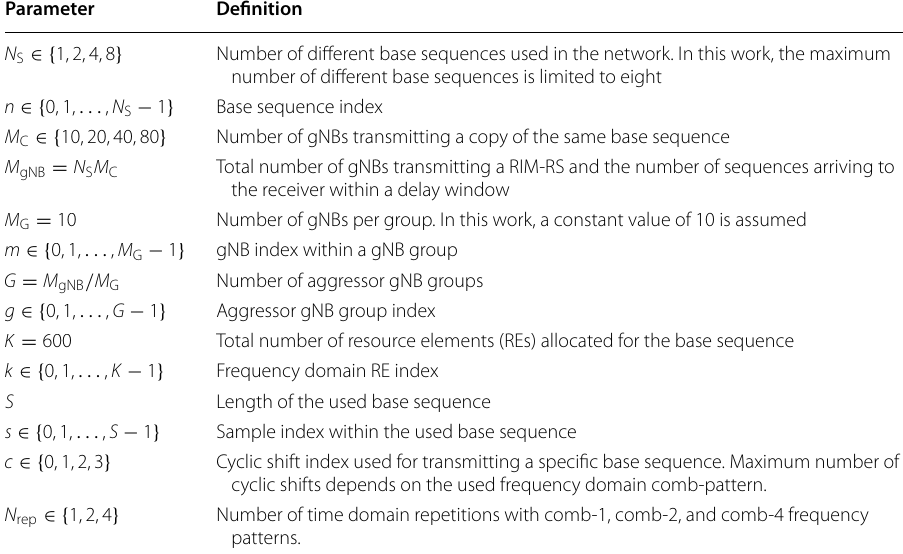
Table 2 Main parameters and their definitions used throughout this paper Parameter Definition